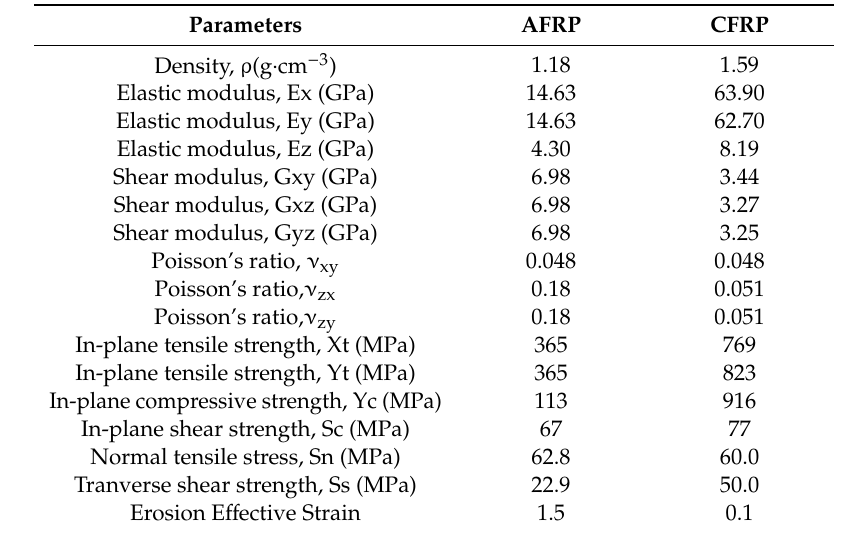
Table 4. Parameters for AFRP and CFRP